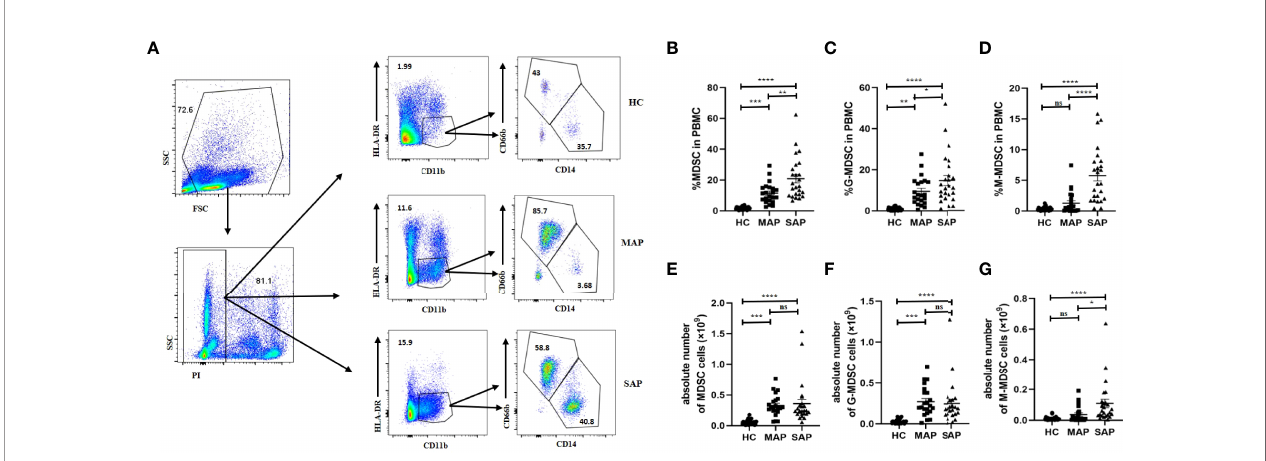
FIGURE 1 | The percentage and absolute number of MDSC in PBMC in patients with AP was increased compared that in HCs. (A) The fl ow cytometry pro fi ling of HLA-DR+CD11b+ MDSCs, and its subsets in PBMC in HC, MAP, and SAP groups. Percentages of MDSC (B) , G-MDSC (C) , M-MDSC (D) and absolute number of MDSC (E) and its subgroups (F, G) are higher in patients with MAP and SAP. * p < 0.05; ** p < 0.01; *** p < 0.001; **** p < 0.0001; ns, not signi fi cant.